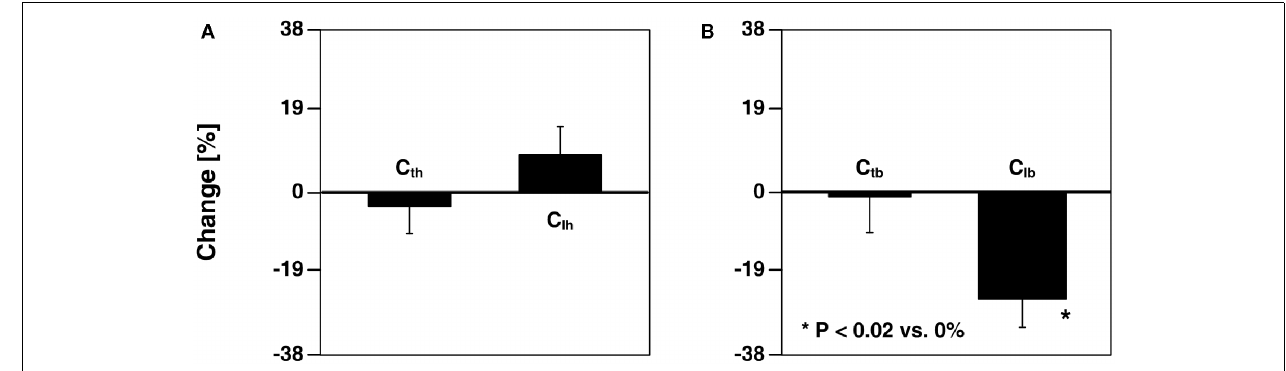
FIGURE 7 | Percent changes in (A) head-end tube and load compliances ( C th and C lh ) and (B) body-end tube and load compliances ( C tb and C lb ) estimated from central aortic pressure and flow and descending aortic flow waveforms after inflation of a balloon in the left external iliac artery. Adapted from Shroff et al.